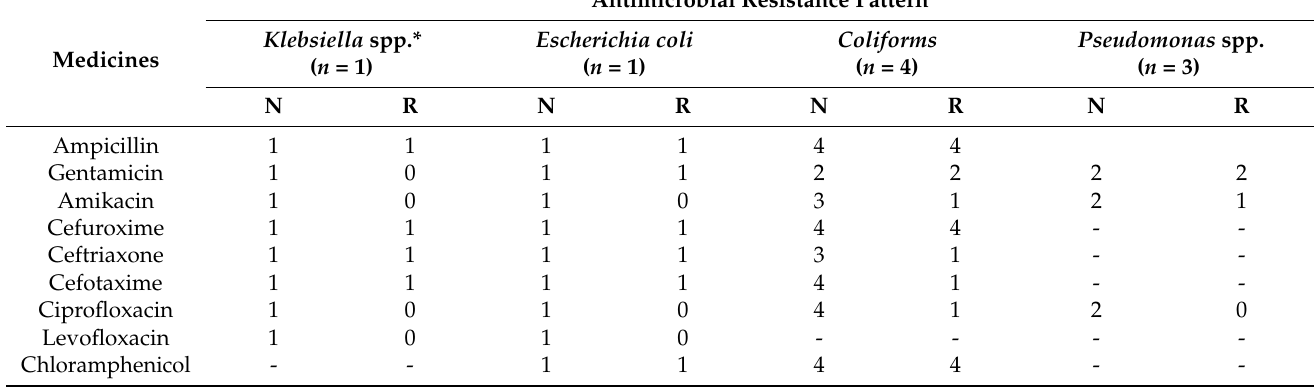
Table 8. Antimicrobial resistance patterns of Gram-negative isolates from blood samples of neonates admitted with suspected sepsis at Komfo Anokye Teaching Hospital, Ghana, between January 2021 and December 2021.